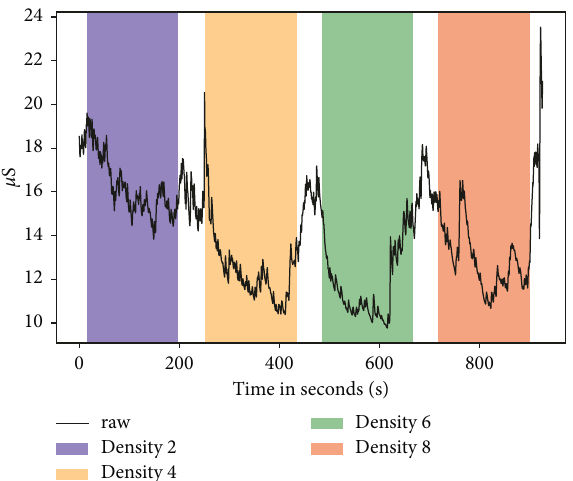
Figure 3: Overall representation of the EDA signal during the whole experiment of a selected person. The colored areas show the different experimental runs, starting with a density of two (purple), then four (yellow), six (green), and eight (red).